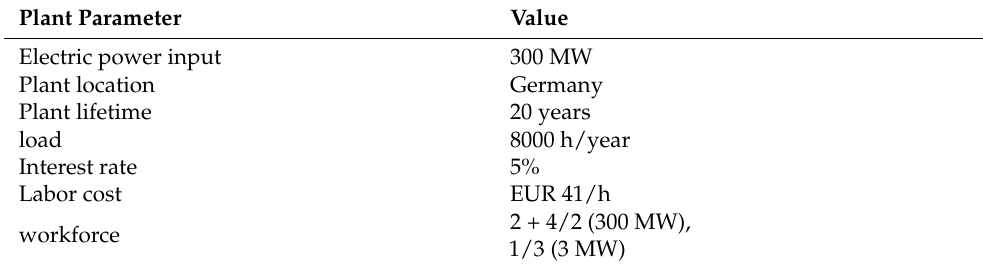
Table 2. Plant parameters.